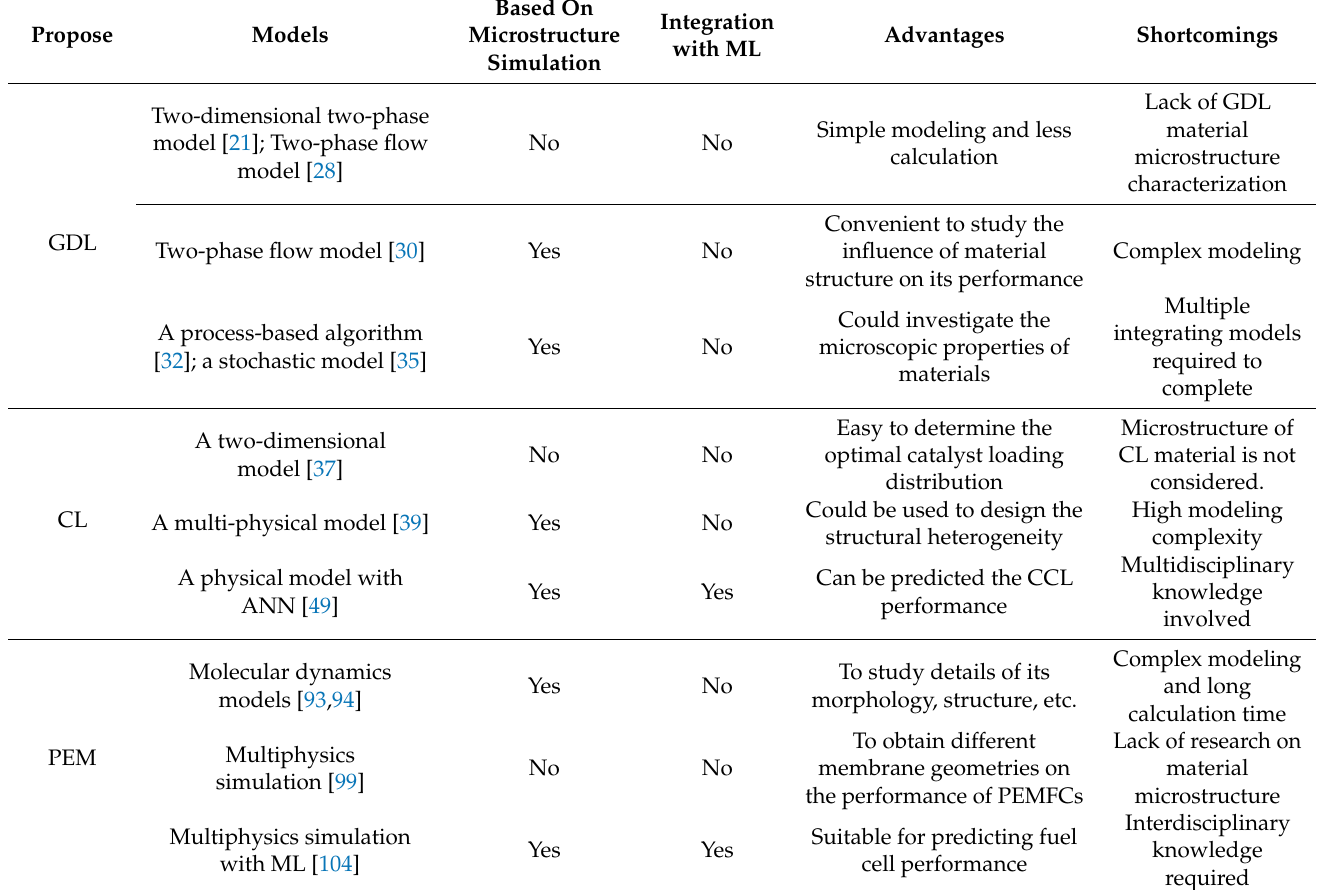
Table 4. Comparison of different models of PEMFCs grouped by GDL, CL and